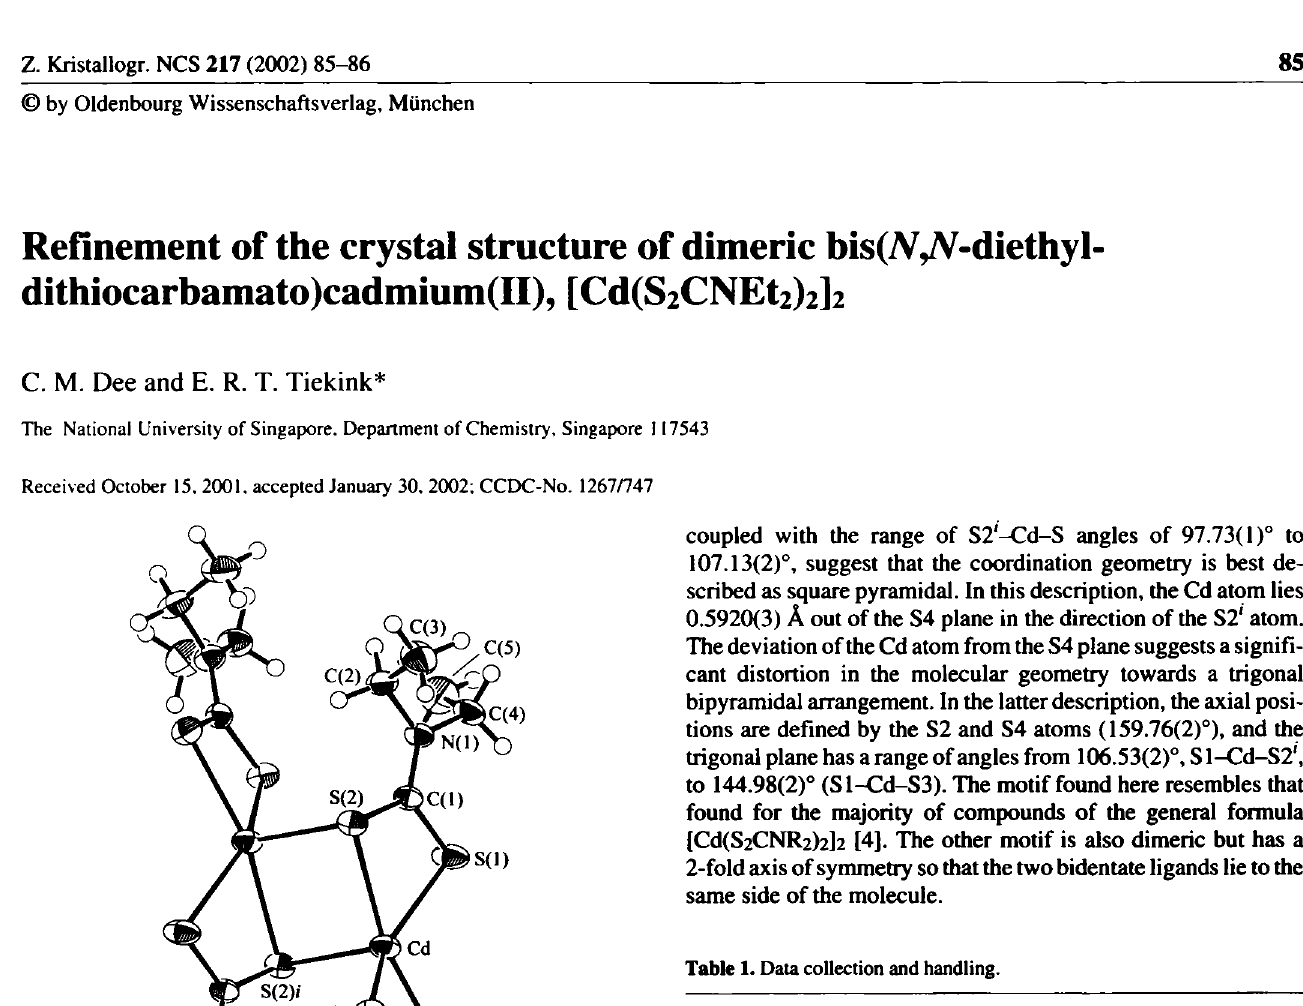
Table 1. Data collection and handling.